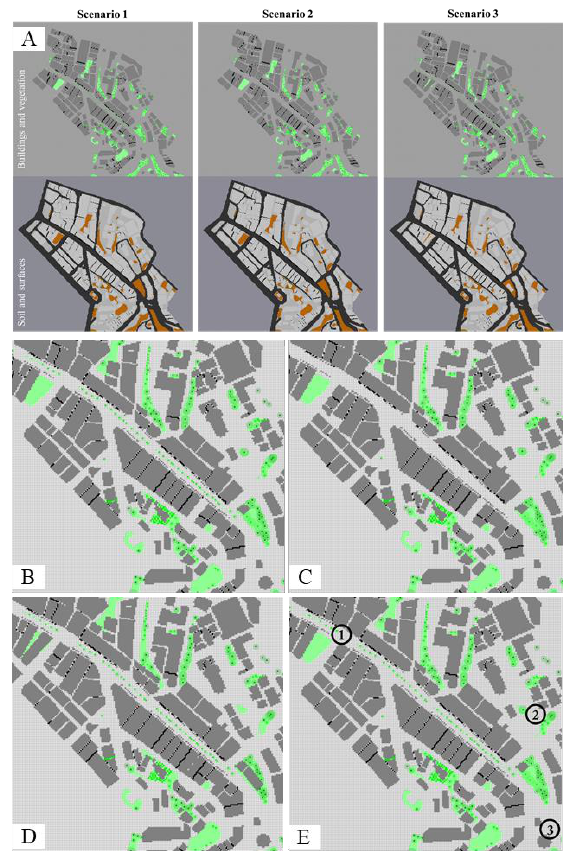
Figure 5. A. ENVI-met simulation models of the three scenarios, showing the building and vegetation layers (top), and soil and surfaces layers. B to D. Zoomed areas showing the difference between the vegetation (green) and building structures (gray) across the scenarios: Scenario 1 or the current scenario (B), Scenario 2 where all Balete trees were removed (C), and Scenario 3 with 10 new buildings added and 30 pine trees removed (D). E. Three smaller subsites were selected within the study site to observe the localized air temperature differences among the three scenarios.